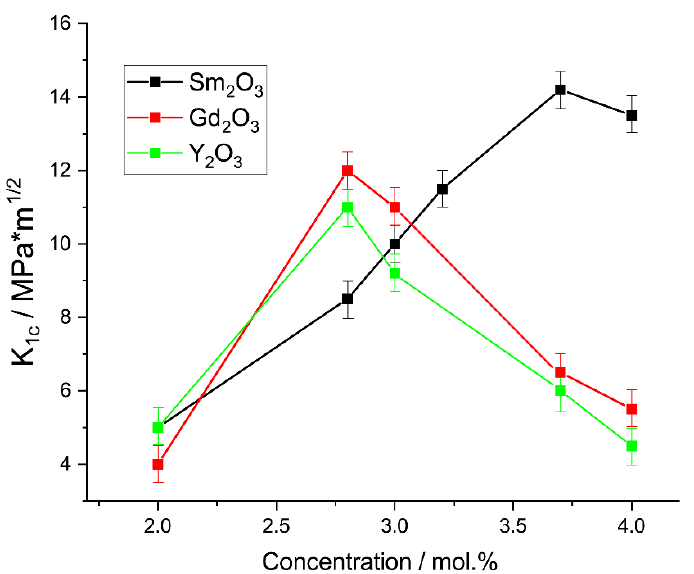
Figure 7. Fracture toughness of (1) (ZrO 2 ) 1 − x (Sm 2 O 3 ) x , (2) (ZrO 2 ) 1 − x (Y 2 O 3 ) x and (3) (ZrO 2 ) 1 − x (Gd 2 O 3 ) x crystals as a function of stabilizing oxide concentration,.